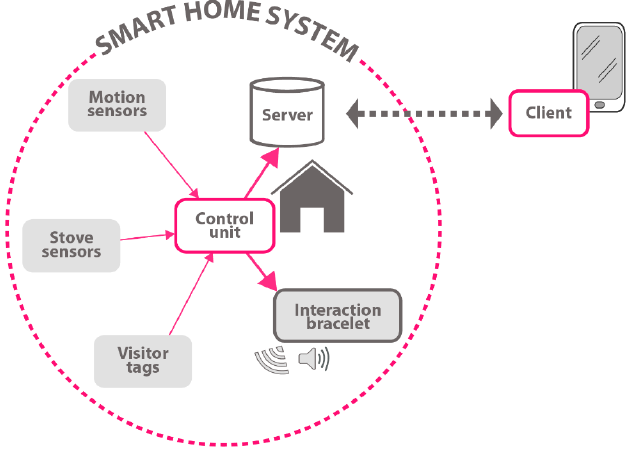
Figure 3. The view of a smart home.